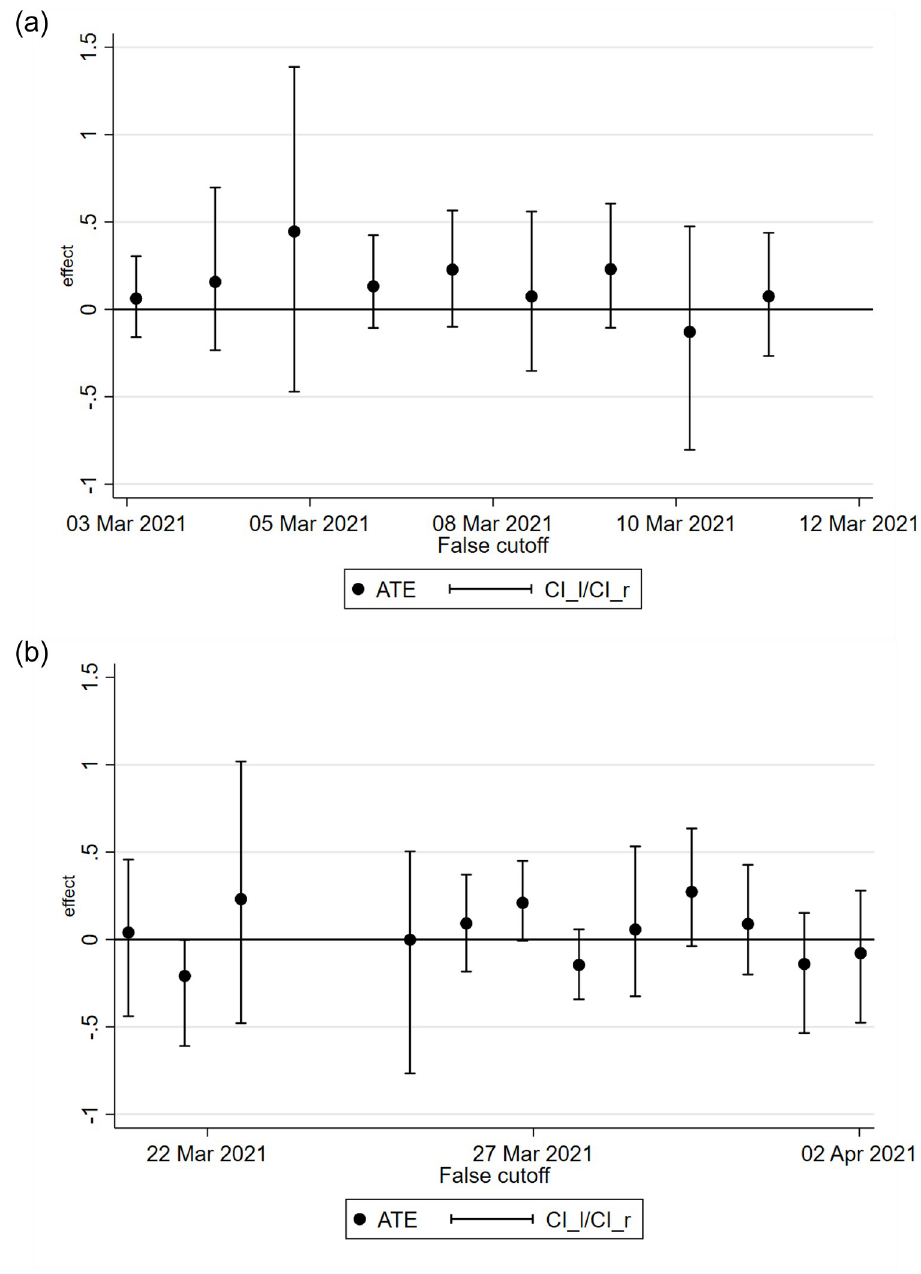
Fig 4. Placebo tests. Notes : Placebo tests point estimates and confidence intervals. The dependent binary variable is equal to 1 if the individual answers that they are willing to get vaccinated. In these placebo tests, z is the running variable on the time of survey completion, with a cut-off at 17:00 for each day to the left (graph (a)) or the right (graph (b)) of the true discontinuity (17:00 on the 18th of March). The missing point estimates are due to the low number of observations around some false cut-off points, which prevents the implementation of the RDD estimator. We follow Cattaneo14 with the following options: triangular kernel; variance-covariance matrix estimated using the heteroskedasticity-robust nearest-neighbour variance estimator and local linear polynomial regression based on the MSE-optimal bandwidth selector for each side of the cut-off.